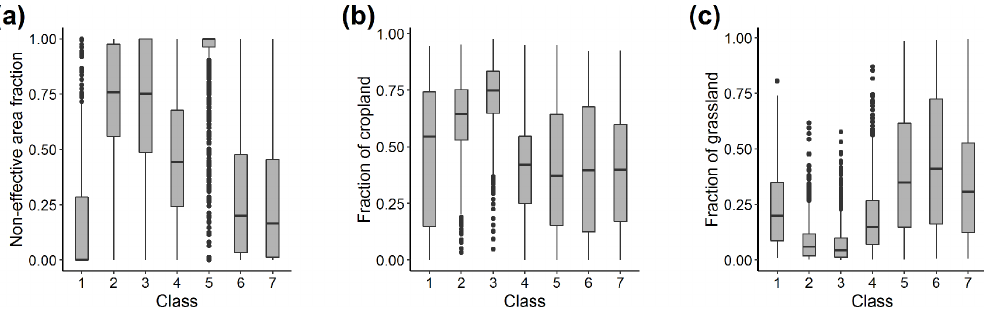
Figure 7. Boxplots of select variables by watershed class: (a) fraction of non-effective area; (b) fraction of cropland; and (c) fraction of grassland. Classes: (1) Southern Manitoba, (2) Pothole Till, (3) Pothole Glaciolacustrine, (4) Major River Valleys, (5) Interior Grassland, (6) High Elevation Grasslands, and (7) Sloped Incised.